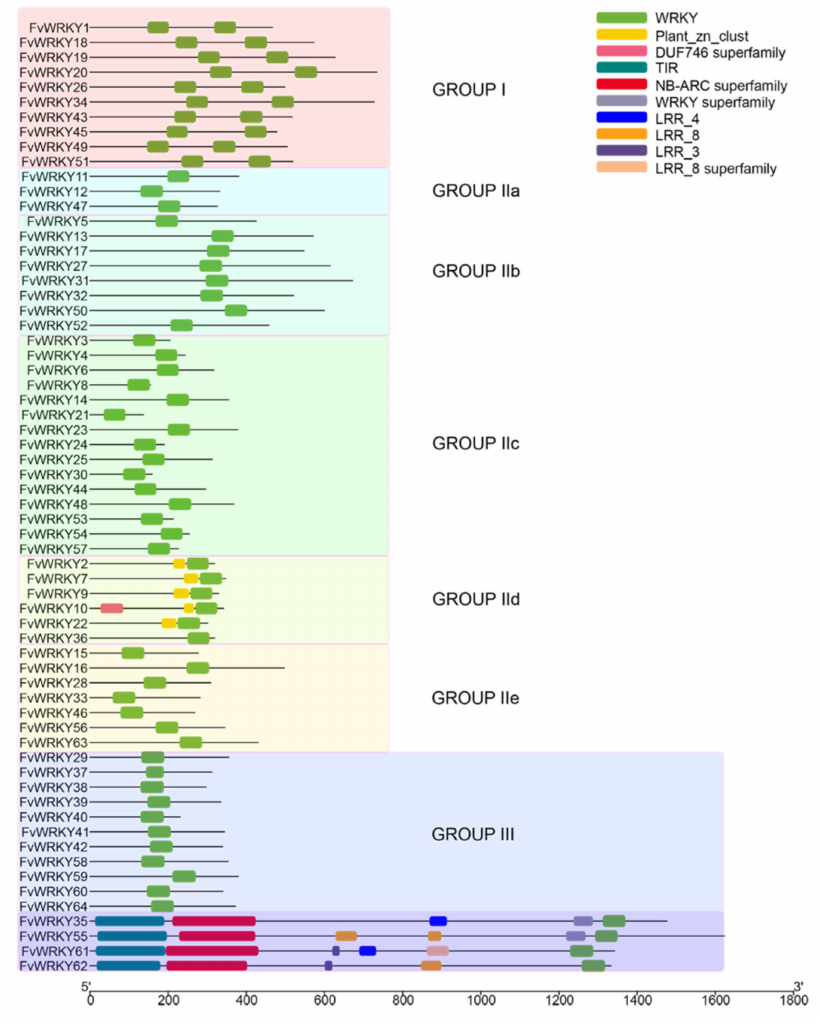
Figure 1. Protein domains (PFAM v32.0) found in FvWRKY proteins. Only the largest splice forms are represented. See Table S2 for more